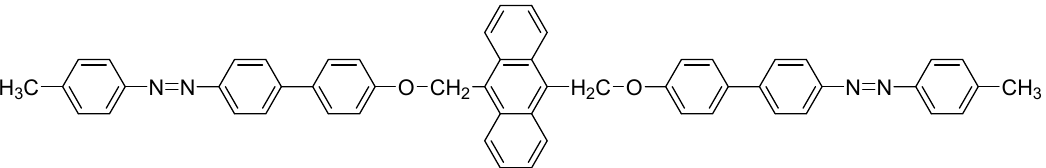
Figure 2. The structural formula of BTA.